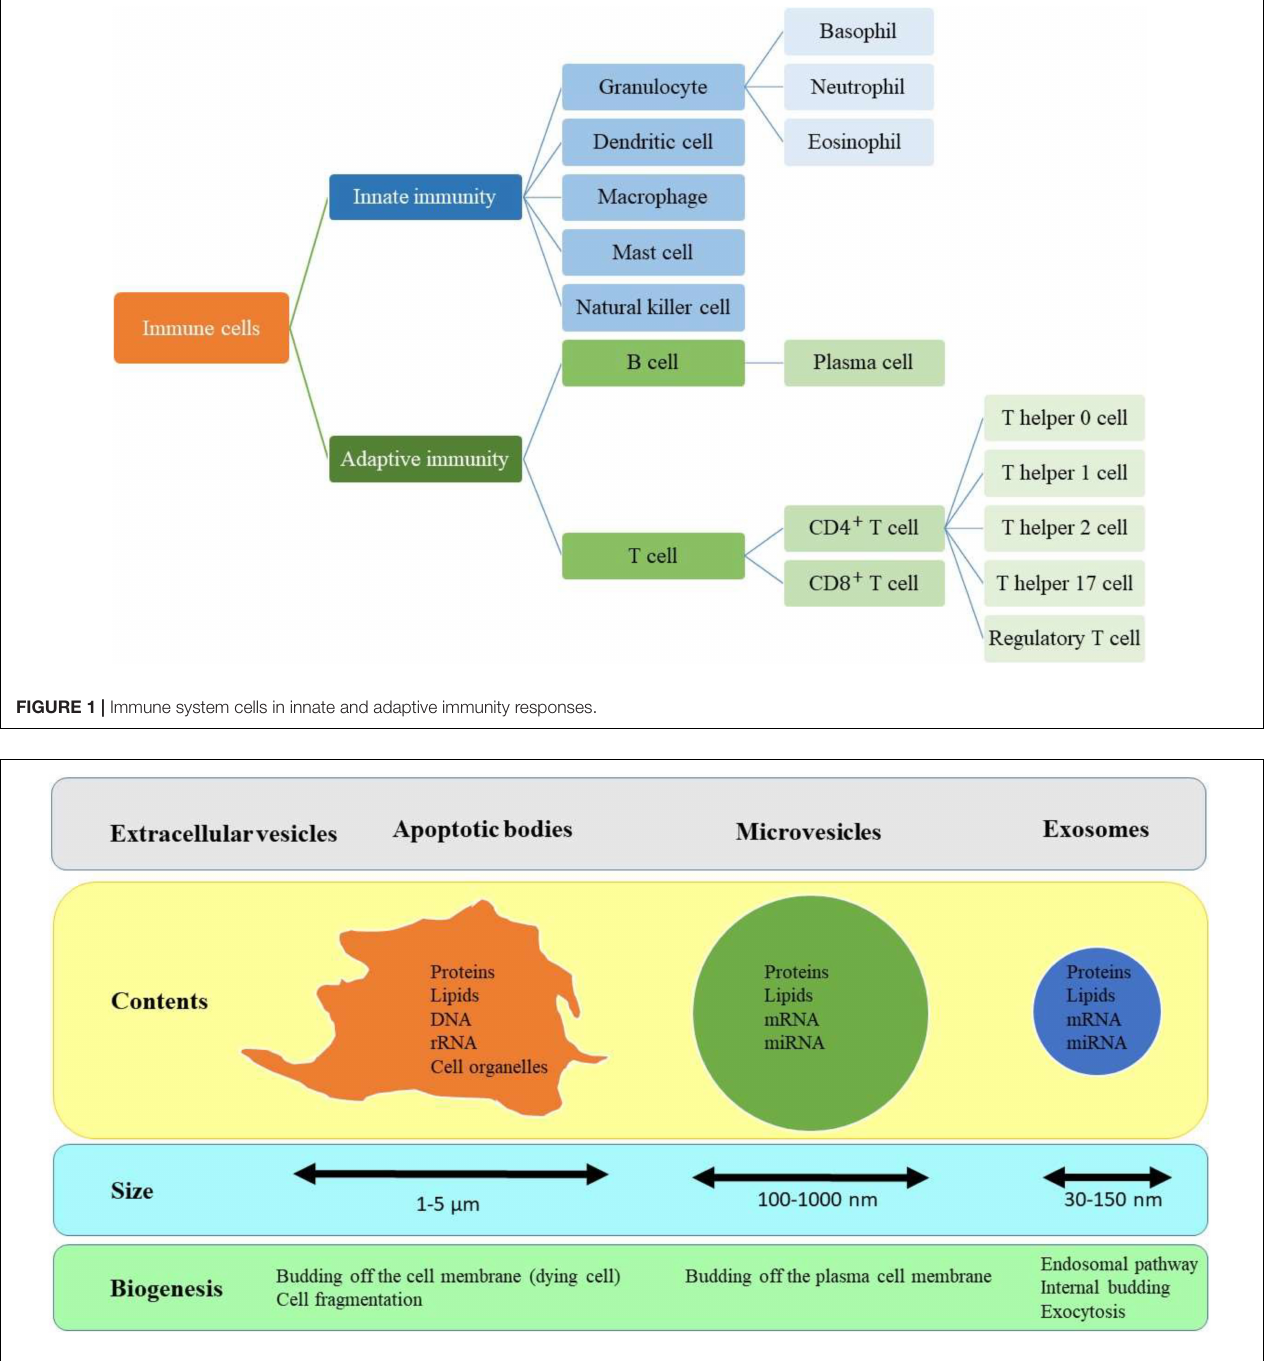
FIGURE 2 | Three main subtypes of EVs and their